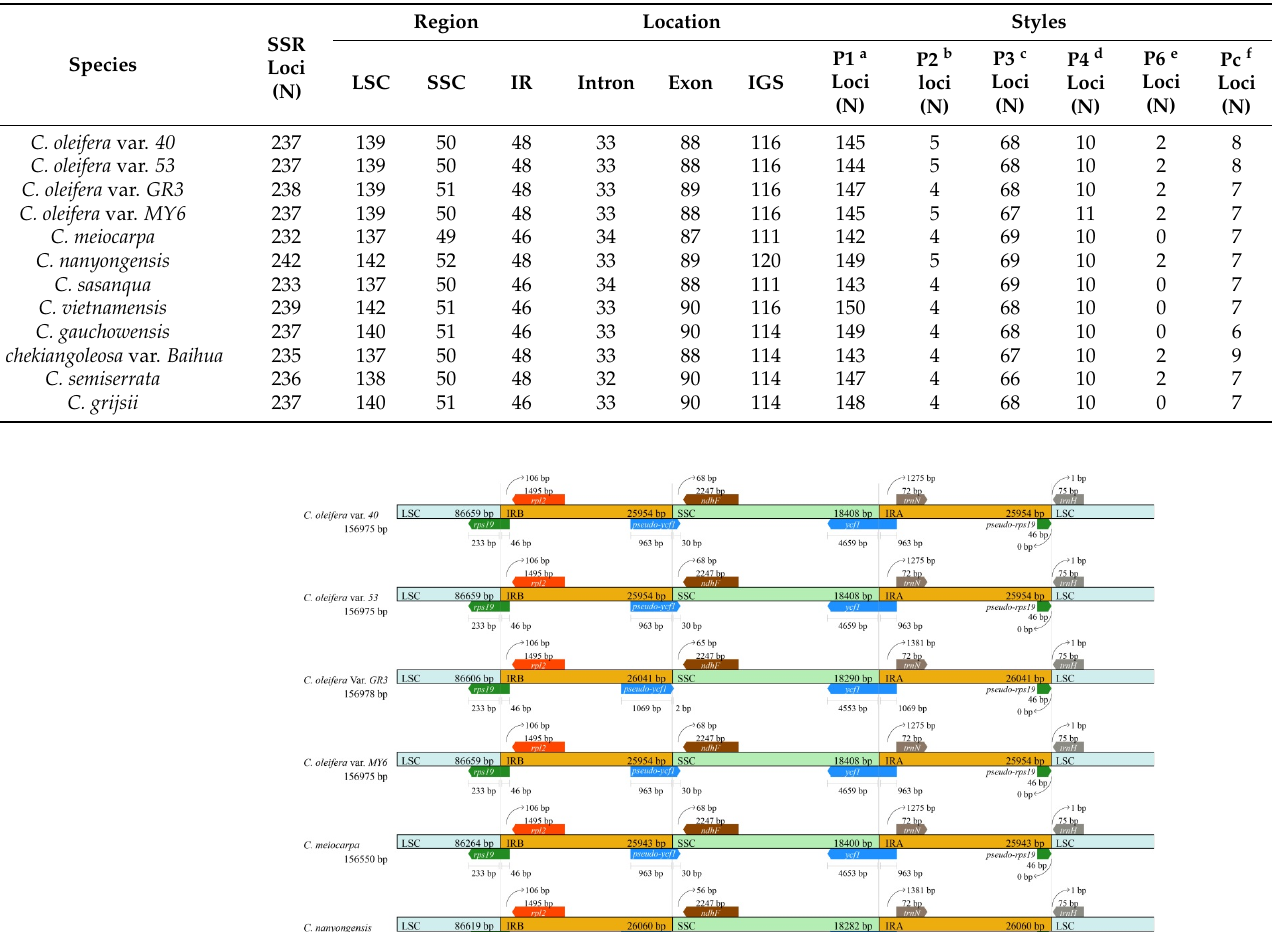
Table 5. Summary of SSRs in the 12 representative Camellia cp genomes.